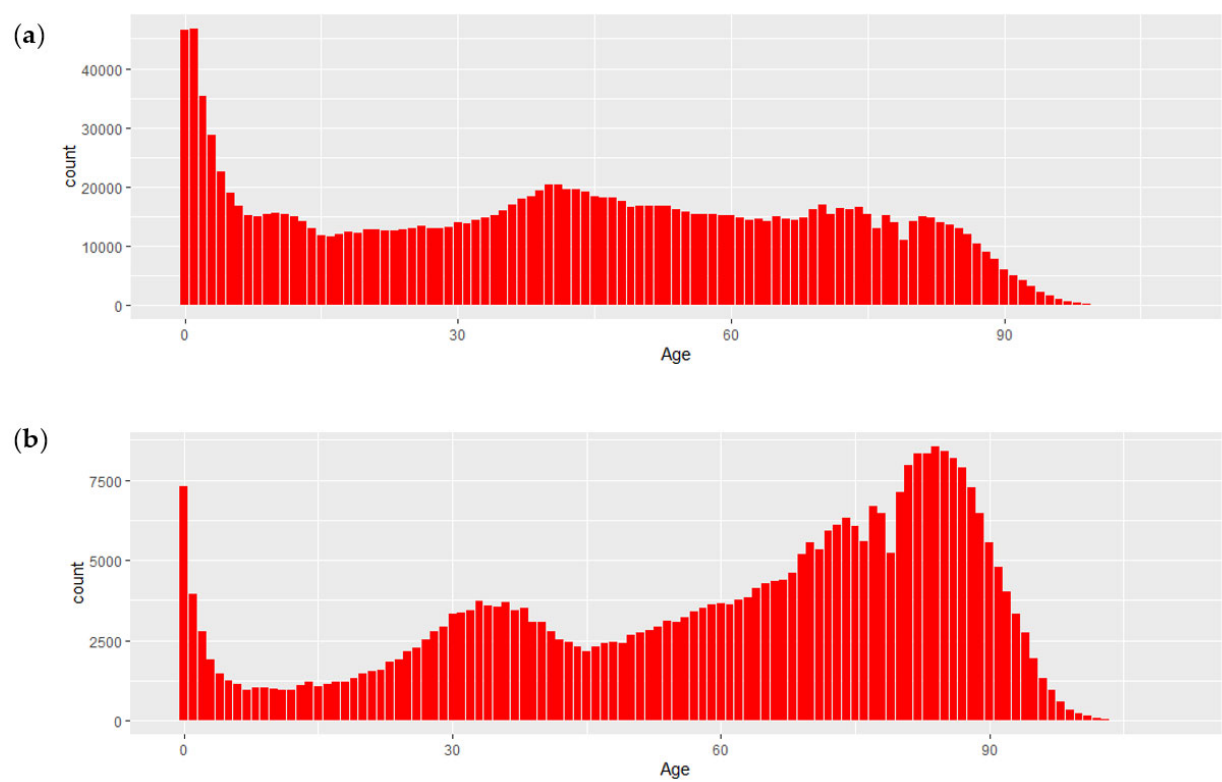
Figure 6. Age distribution patients: ( a ) male patients; ( b ) female patients.